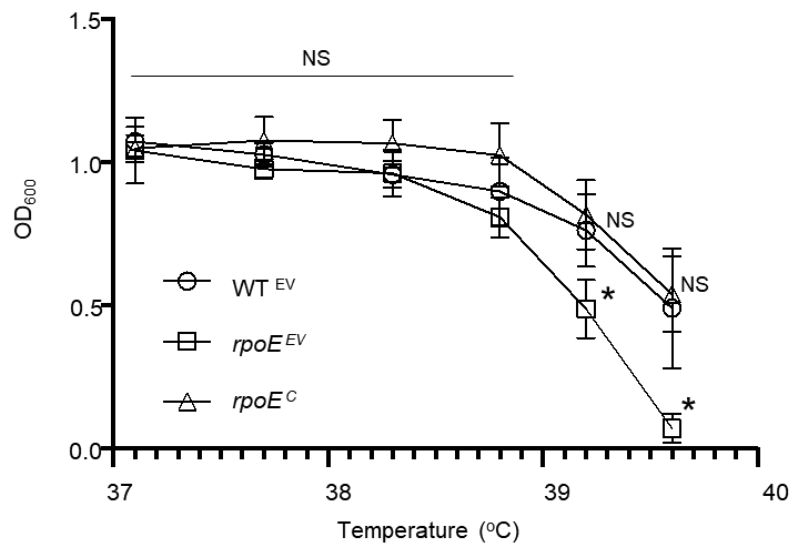
Figure 4. Mutation of rpoE limits the growth potential for GAS at increasing temperatures. Overnight cultures of WT 5448 (WT), rpoE mutant ( rpoE ), or the complemented strain ( rpoE C ) were diluted to a starting OD 600 = 0.05 in fresh THY media; 120 µL of culture was then aliquoted into sterile PCR tubes and incubated in a thermocycler at increasing temperature gradient for 24 h and growth measured by absorbance (OD 600 ). This experiment was performed in six biological replicates. Asterisks indicate statistical significance ( p ≤ 0.05) at indicated growth temperatures of the rpoE mutant by comparison to the WT as determined by an unpaired t -test. NS = not significant.